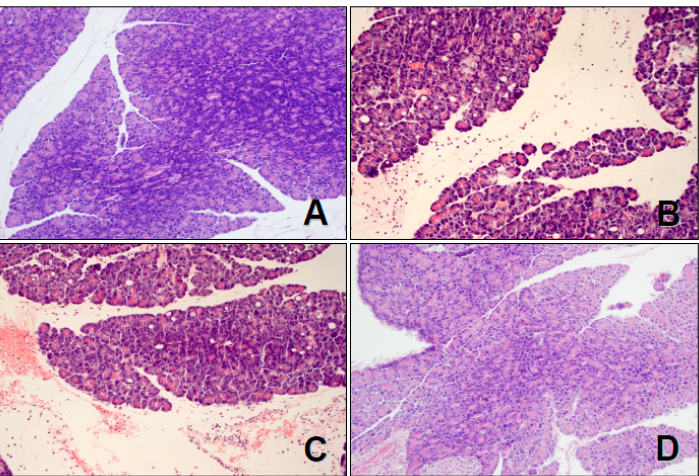
Figure 1. Histological images of pancreatic tissues stained with hematoxylin and eosin, magnification 400 : ( A ) control sensory-nerves-intact rats treated with saline without cerulein-induced pancreatitis (CIP); ( B ) sensory-nerves-intact rats treated with saline followed by CIP development; ( C ) rats with capsaicin deactivation of sensory nerves treated with saline followed by CIP development; and ( D ) sensory-nerves-intact rats treated with ghrelin given at a dose of 50 µ g / kg followed by CIP development. The above errors were without material impact on the final results and conclusions of our papers. We apologize for this inconvenient situation.